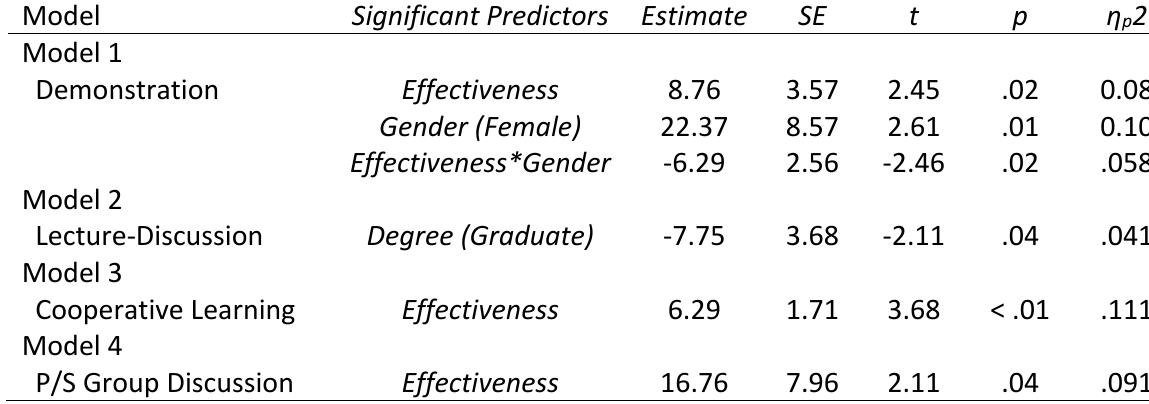
Regression Model Outputs for Factors Predicting Higher Method Use by Method